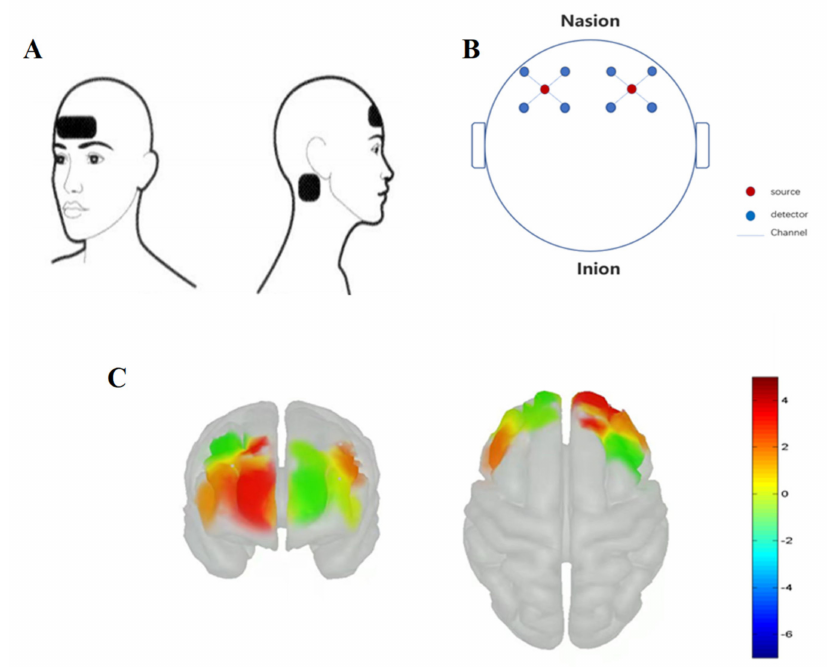
Figure 1. Functional near − infrared channel layout. Note: ( A ) the placement of the electrode sheet; ( B ) the placement of fNIRS over the DLPFC, FPA, and orbitofrontal area; ( C ) the changes in the oxygenated hemoglobin in the frontal lobe stimulated by